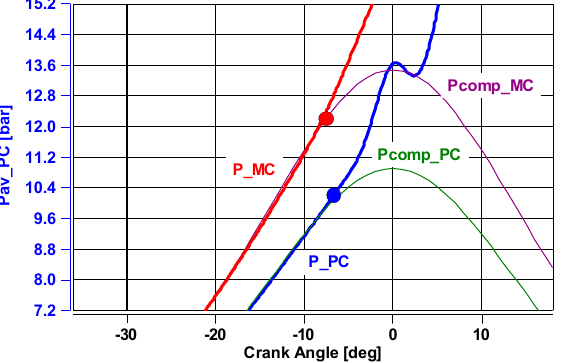
Figure 15. The method of determining the start of combustion at a given pressure in the main chamber and the prechamber of the tested engine (both pressures were presented on a much larger scale than in reality).